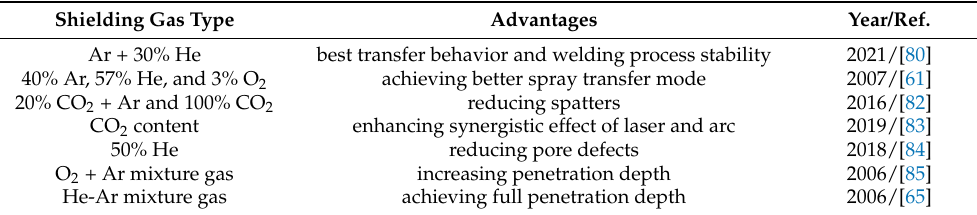
Table 3. The advantages of different shielding gases in this review.